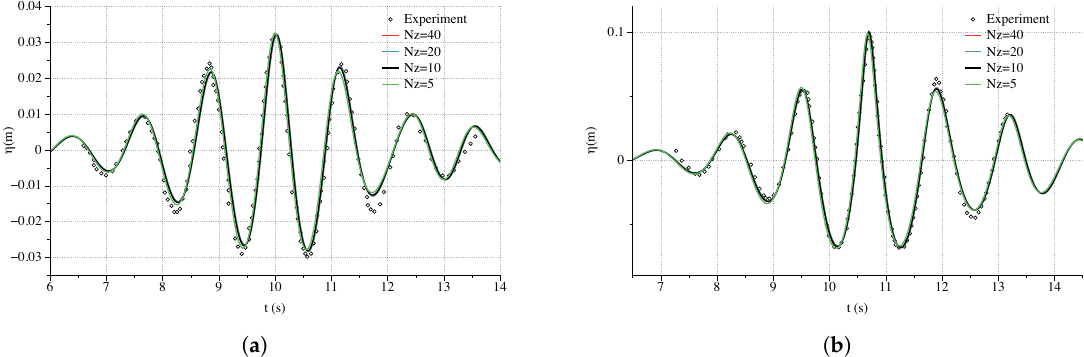
Figure 11. Grid convergence study in the z-direction, ( a ) the time series at the focusing location x = 7.5 m for case NING1, ( b ) the time series at the focusing location x = 8.475 m for case NING3. The tested numbers of grid in the vertical direction are N z = 5, 10, 20 and 40.